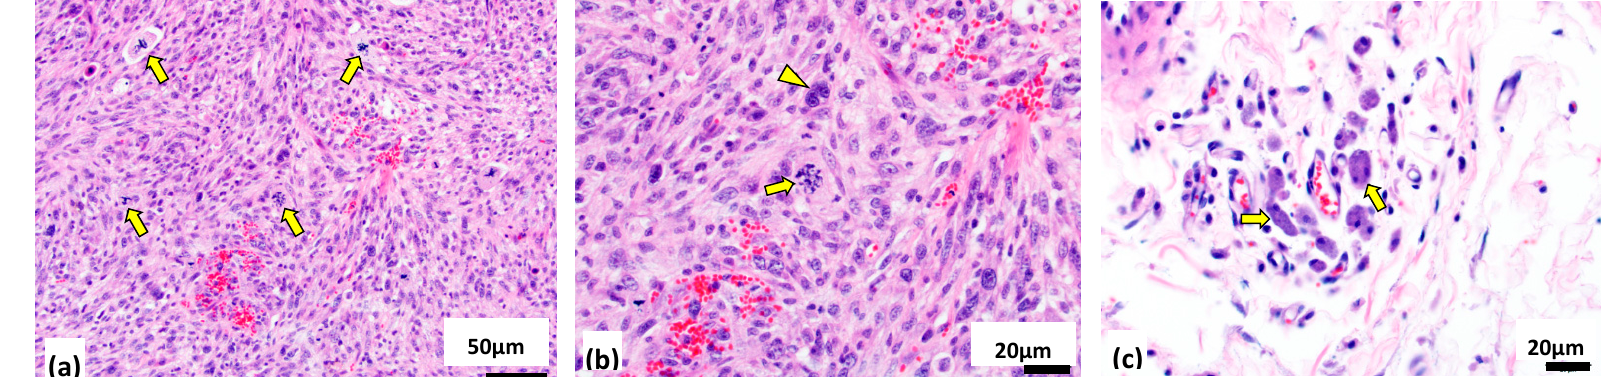
Figure 3. Histologic evaluation of representative hematoxylin and eosin–stained sections of tumor ISS-19a. (a) Assessment at low magnification (200x) demonstrated high mitotic activity (arrows) and an interwoven growth pattern composed of bundles and streams of fusiform to polygonal mesenchymal cells with moderate amounts of eosinophilic cytoplasm surrounding large, irregularly round nuclei. (b) Evaluation at higher magnification (400x) identified anaplastic cellular features, frequent anisocytosis and anisokaryosis, multinucleated giant cells (arrowhead) and bizarre mitoses (arrow). (c) At the periphery of the tumor was an inflammatory infiltrate composed predominantly of small lymphocytes and macrophages (arrows) bearing an intracytoplasmic blue-grey material, consistent with the presence of aluminum-based adjuvant. Histologic features were highly conserved between ISS-19a (56 mitotic figures per ten 400x fields of view) and ISS-19b (47 mitotic figures per ten 400x fields of